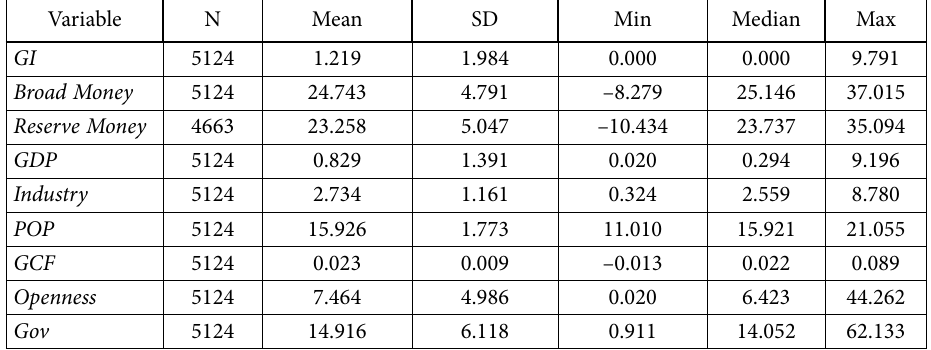
Table 2. Summary